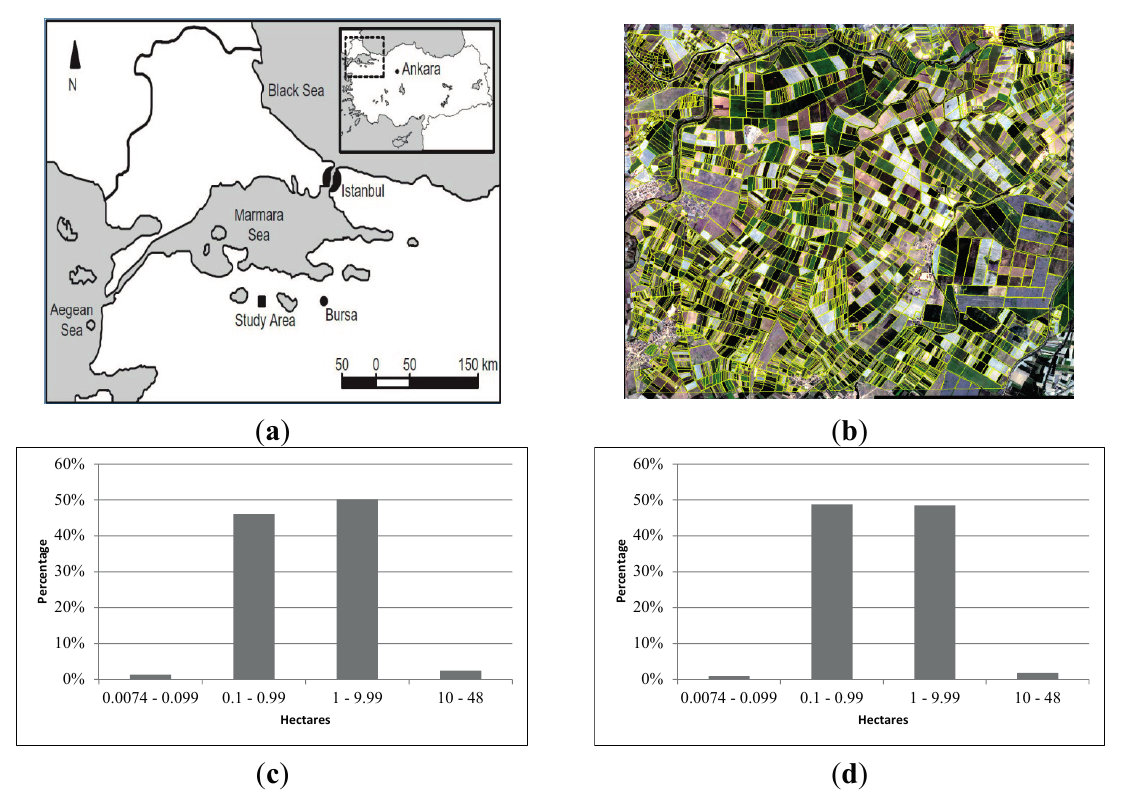
Figure 1. ( a ) Study area, ( b ) Ikonos image (RGB) overlaid with the parcel boundaries (in yellow color). ( c ) and ( d ) Histogram showing the distribution of agricultural fields with respect to their sizes (ha) in years 2004 and 2008,